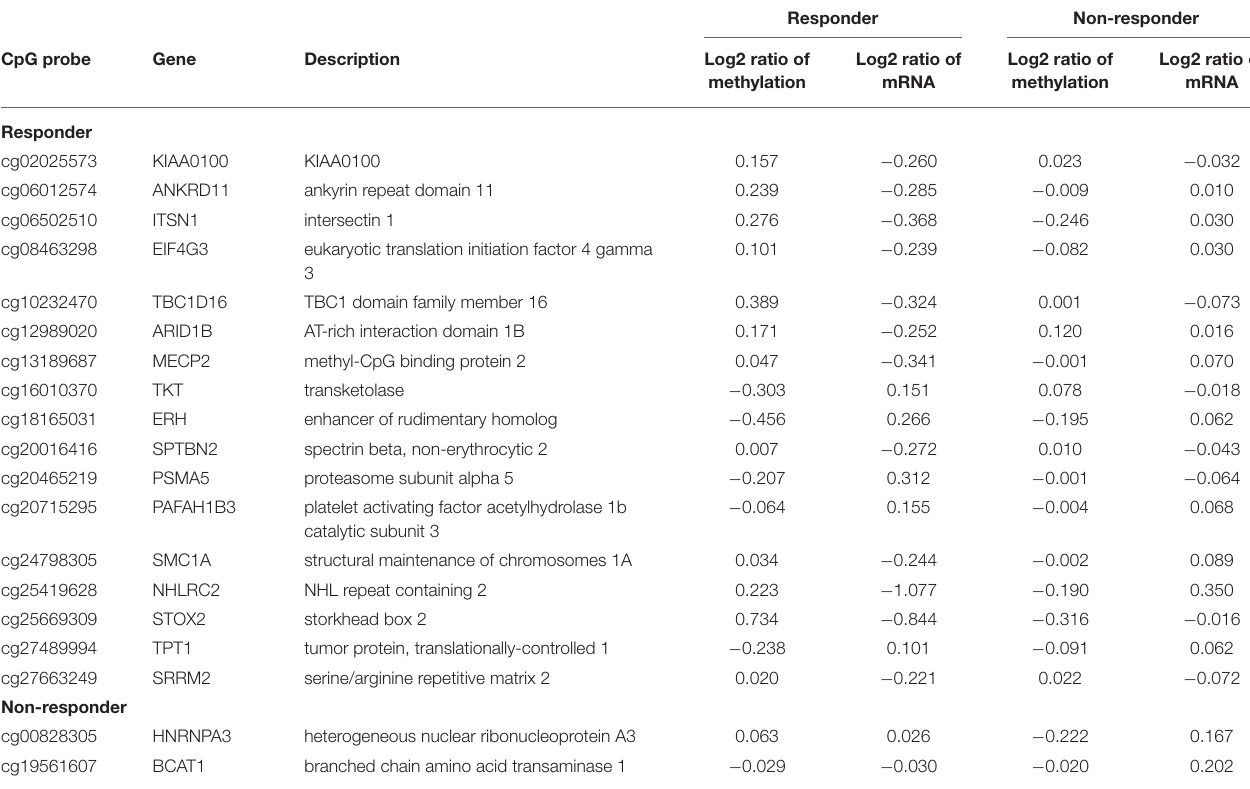
TABLE 1 | Genes changed in the opposite direction to promoter CpG sites in response to